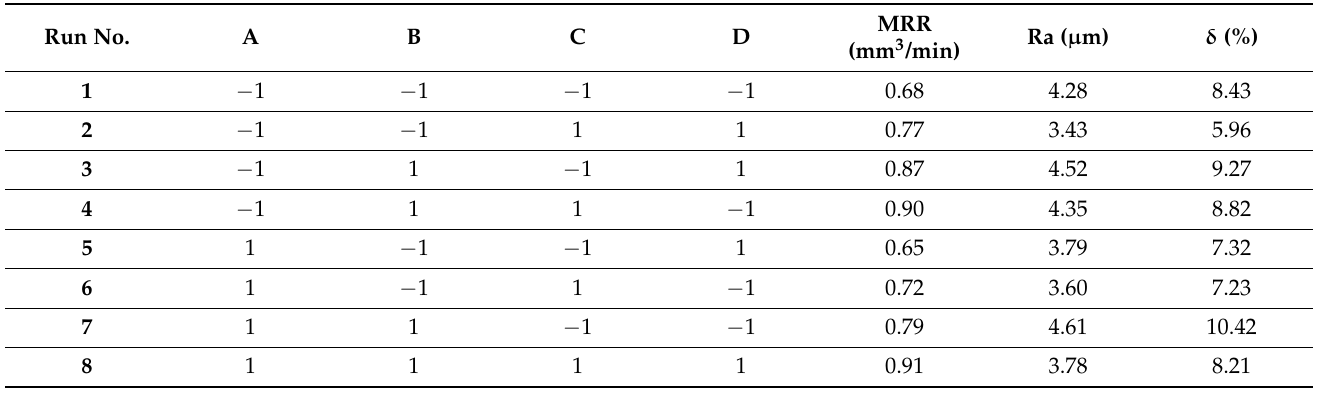
Table 5. Results of the orthogonal analysis.